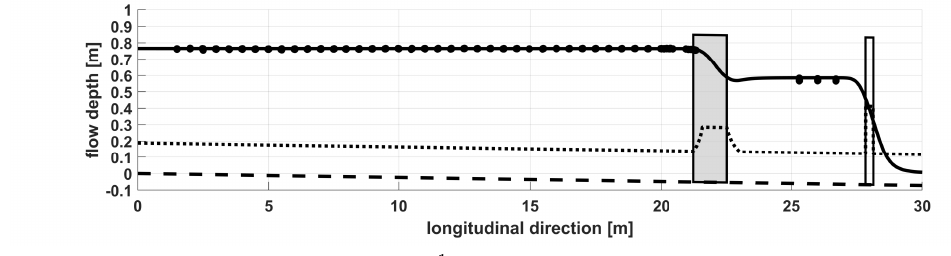
Figure 8. Comparison of measured and simulated flow depth for ( a ) the free outflow, ( b ) the medium submerged flow, and ( c ) the full submerged flow for the exemplary results from Figure2. Using the Saint-Venant equations enables to simulate the flow depth profile from the experiments very accurately. The normal water depths listed in the subscriptions are calculated from